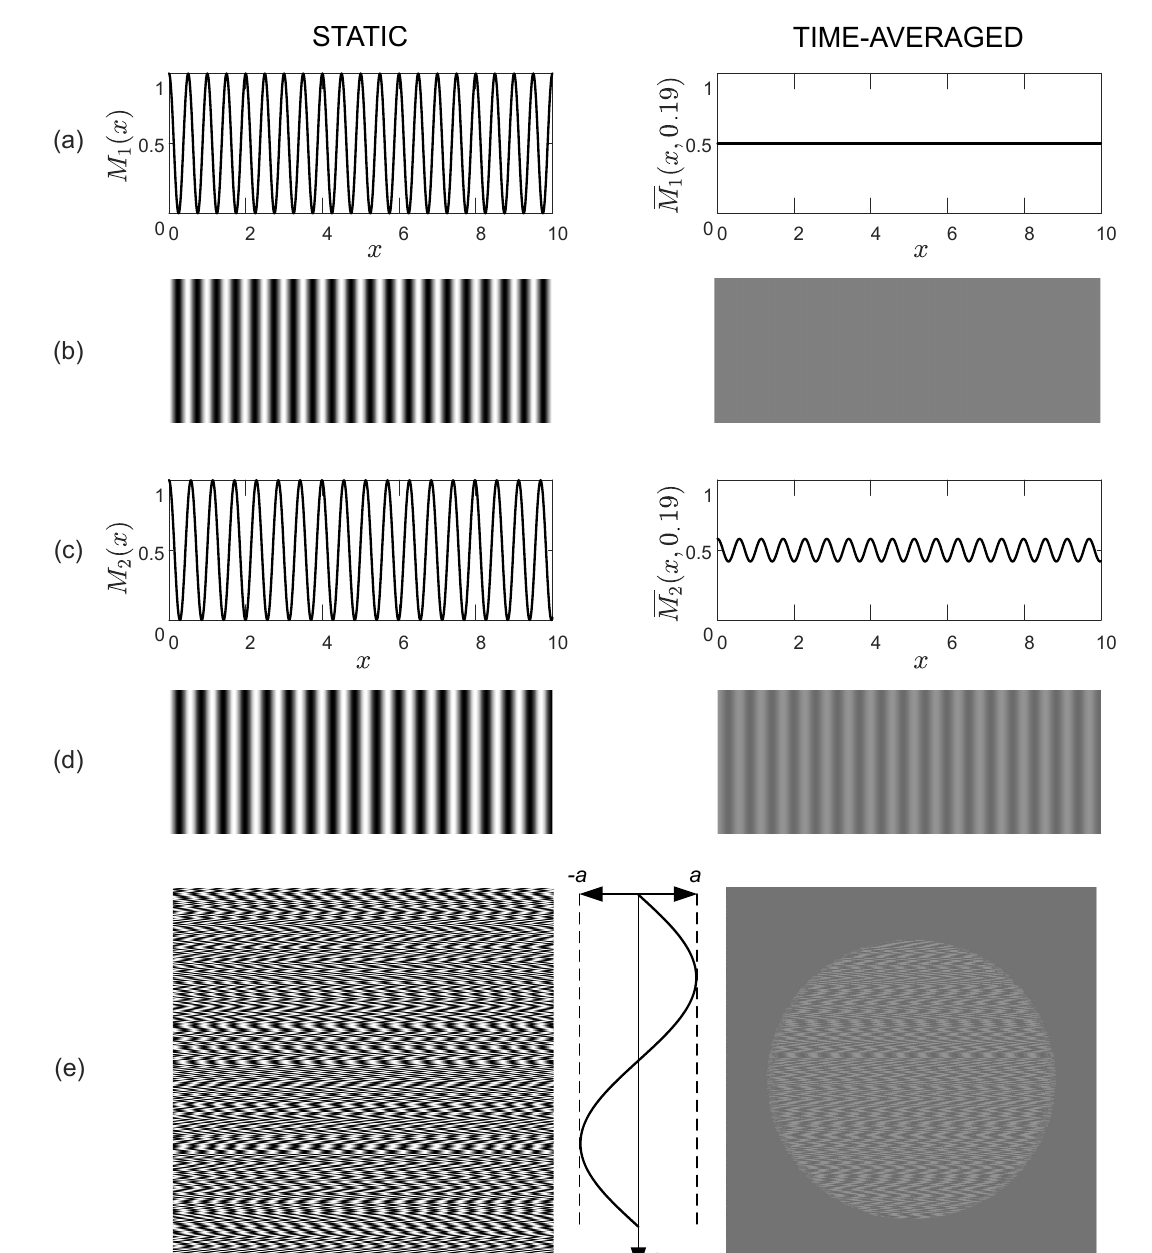
Figure 2. A schematic illustration of the DVC scheme based on two harmonic moiré gratings. Two moiré gratings ( M 1 ( x ) and M 2 ( x ) ) with slightly different pitches (depicted in panels ( a , c )) are used to represent the background and the secret (the circle); their optical representations are shown in panels ( b , d ). The static and time-averaged cover image is shown in panel ( e ). The amplitude of harmonic oscillation a is chosen in such a way that the time-averaged moiré fringe is not fully developed in the area occupied by the secret